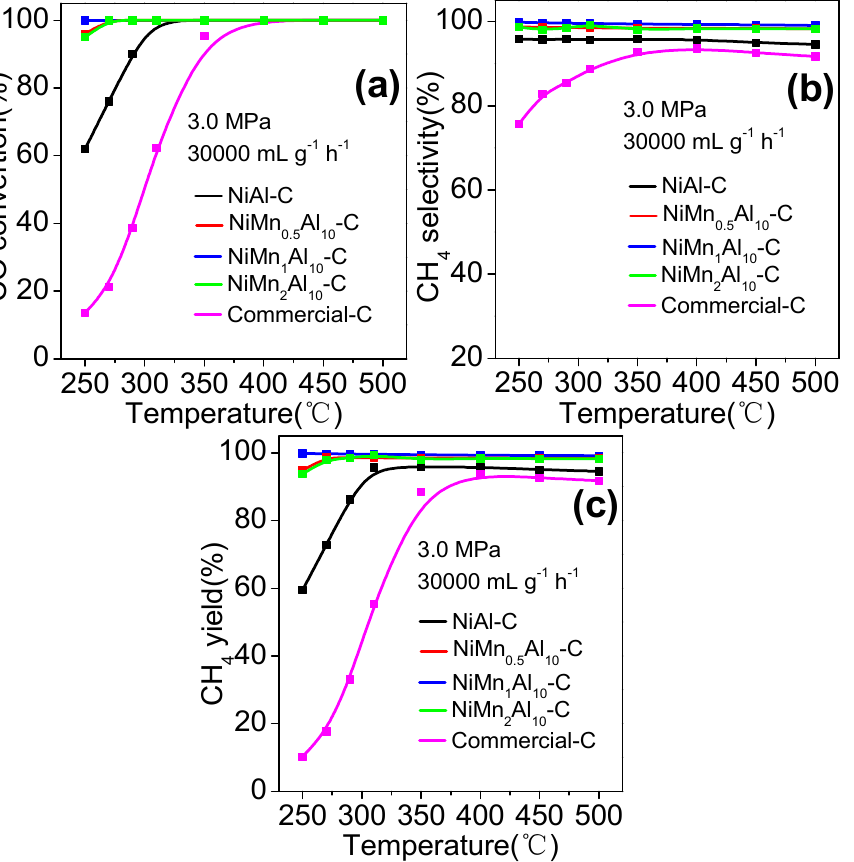
Figure 9. Catalytic activity of the catalysts for CO methanation: ( a ) CO conversion, ( b ) CH 4 selectivity, ( c ) CH 4 yield.